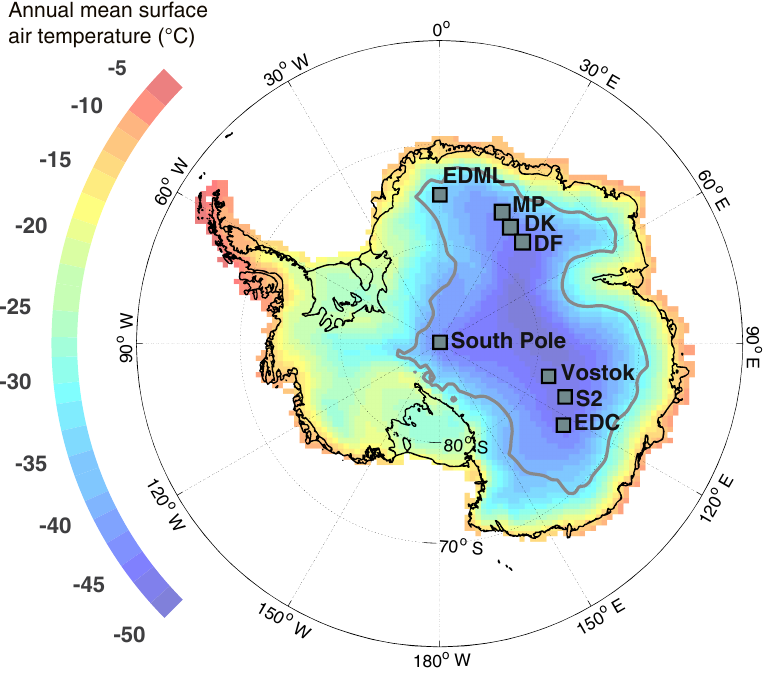
Figure 2. Location of the sampling sites used in this study (solid squares). The 2500ma . s . l . elevation contour is marked by a grey line; colours indicate the annual mean surface air temperature (Nicolas and Bromwich,